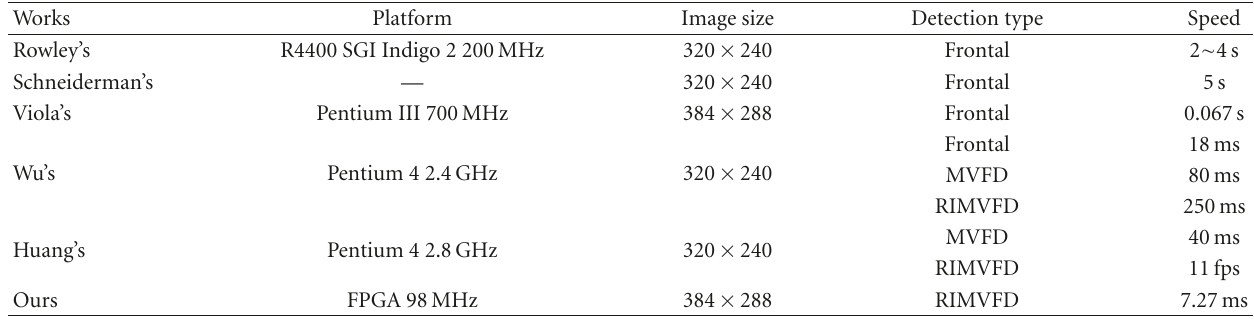
Table 7: Performance comparison with related works.